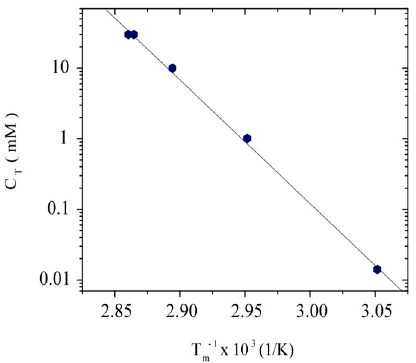
Figure 3. Variation of T m with the total ionic concentration for different DNA concentrations and external salt contents.